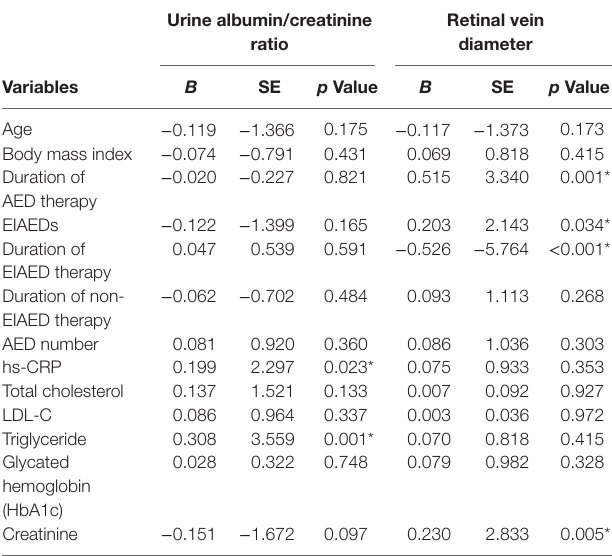
TaBle 4 | Multiple linear regression analysis of association of microangiopathy with duration of AED therapy and other candidate risk factors.